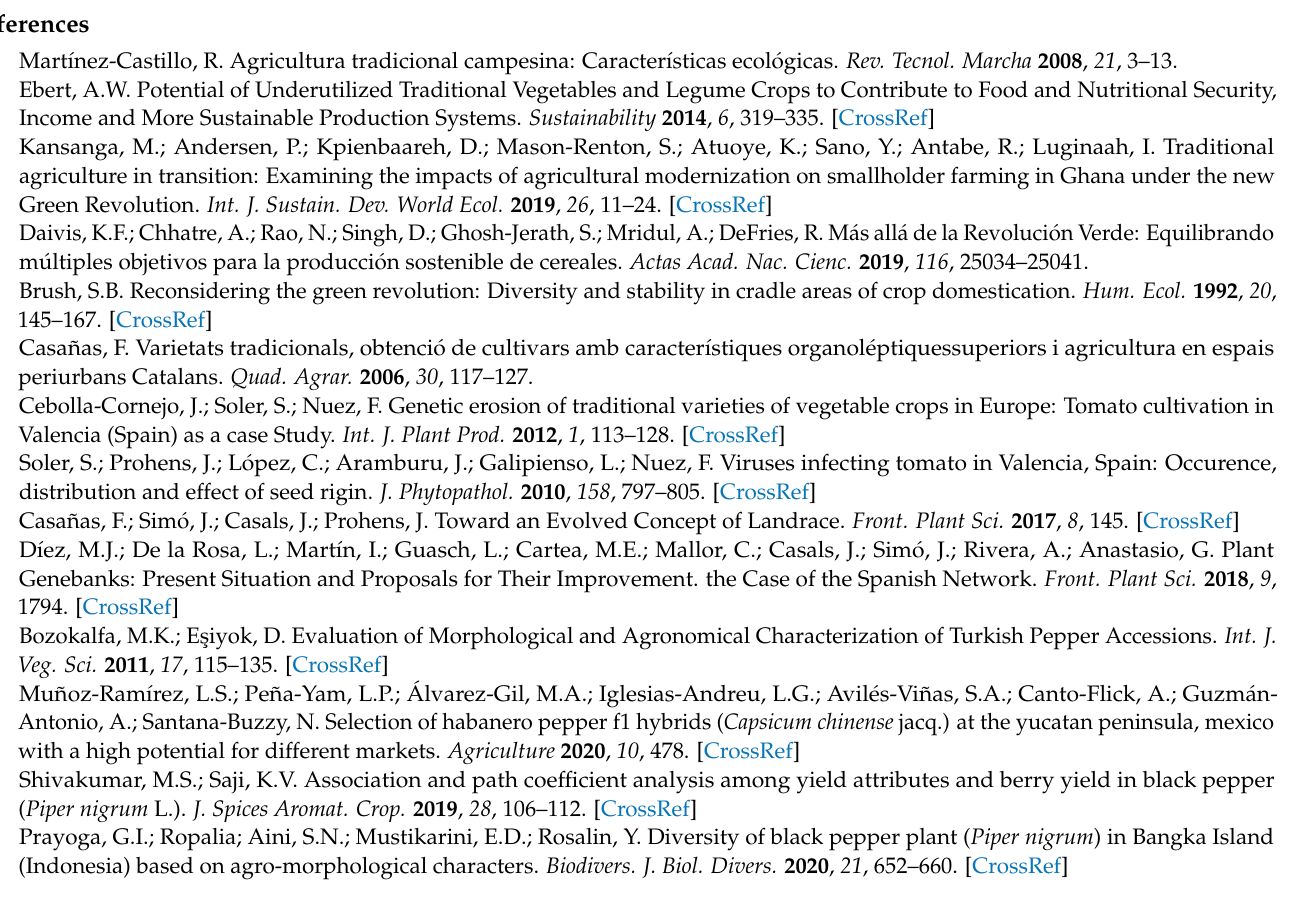
traits; Figure S2: Frequency distribution of fruit traits; Figure S3: trait contribution to PC1; Figure S4: PCA analisi for the first four PCs; Figure S5: Dendrogram; Table S1: Descriptors used for phenotyping; Table S2: Descriptive statistics of quantitative traits; Table S3: PCA components; Table S4: Correlation coeficients for the first four PCs; Table S5: Linear correlation analysis